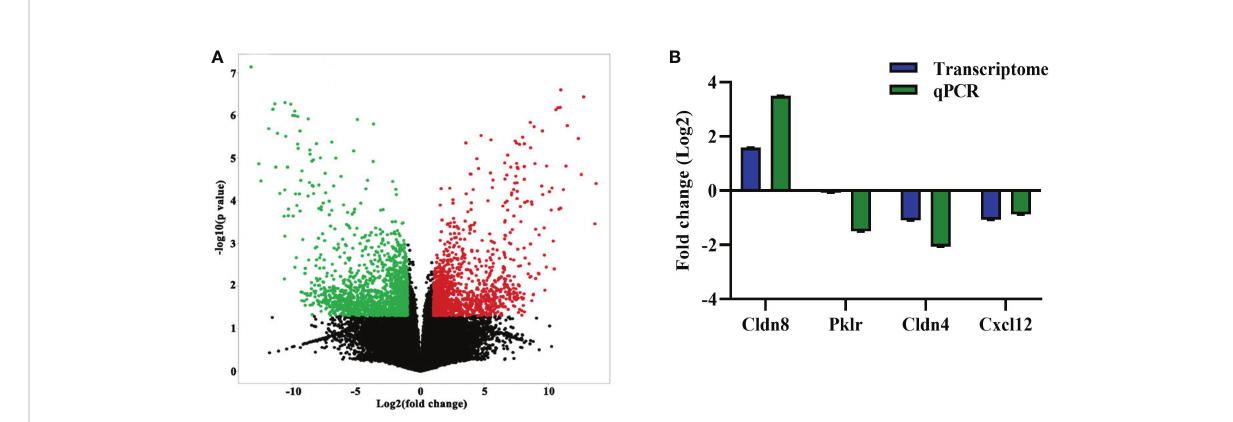
FIGURE 2 The identi fi cation and validation of differentially expressed mRNAs in the colonic tissues post the protoscoleces of Echinococcus granulosus infection. (A) The volcano plot shows the distributions of mRNAs between the Control and Infected group. The signi fi cantly upregulated and downregulated RNAs are presented as red and green dots, respectively, whereas the black dots represent the mRNA with no signi fi cant difference ( n = 3). (B) qPCR validation of randomly selected mRNAs from the RNA-seq data ( n = 4 -